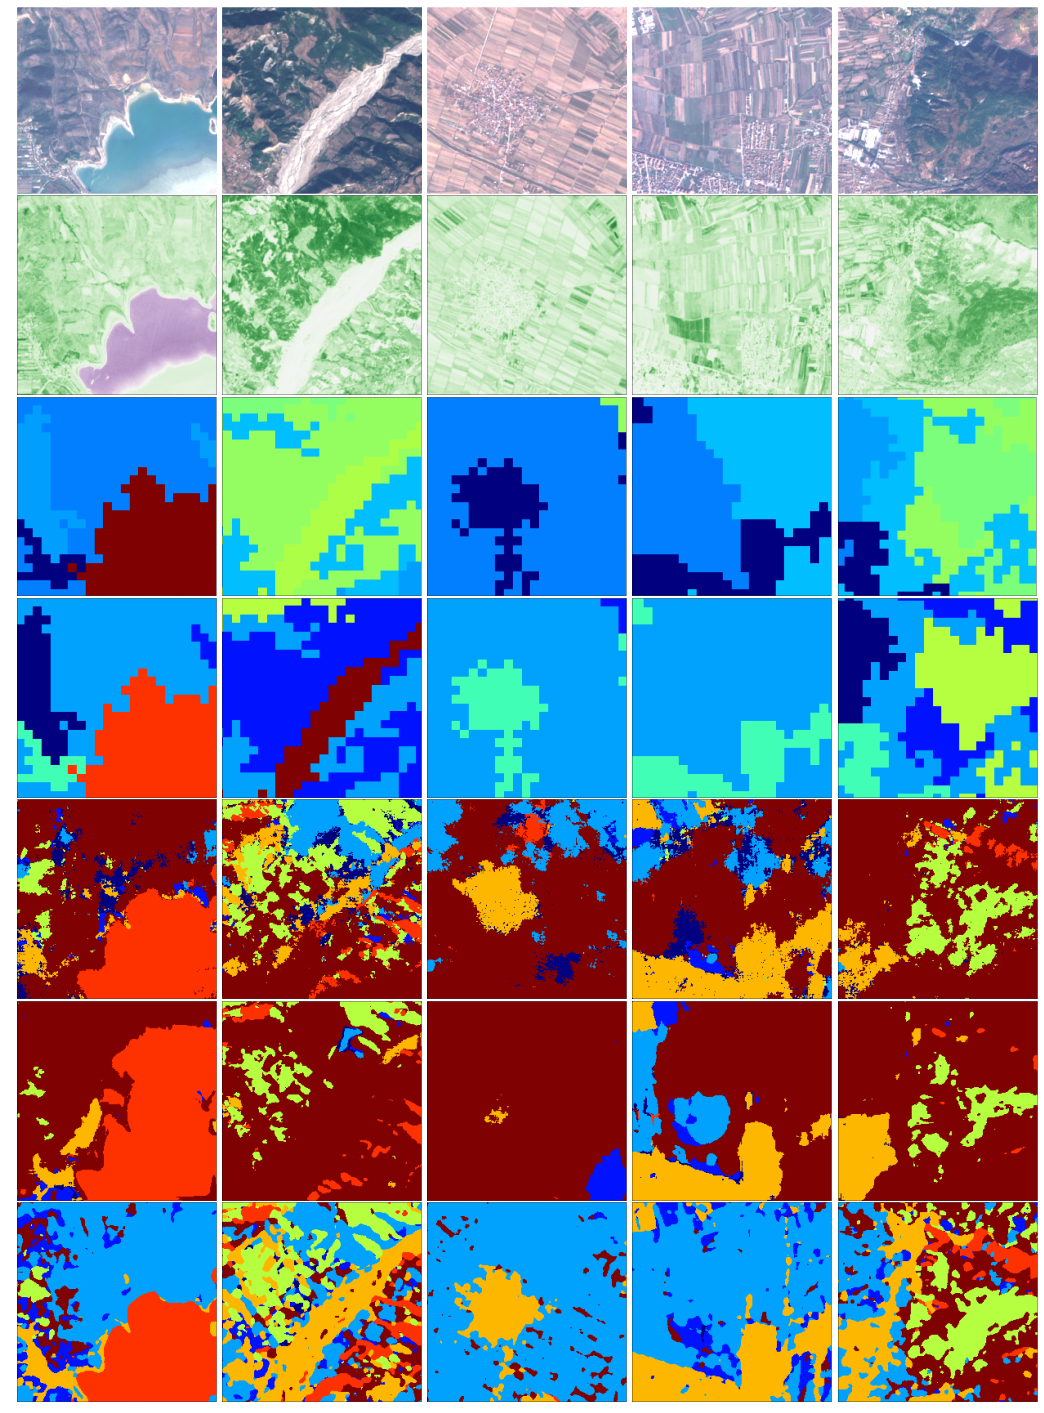
Figure 9. Checking the model robustness. Area of study: Albania. Reference layer: CORINE 2018 re-classified. Rows: (1) RGB composition of the input S2 imagery; (2) NDVI; (3) CORINE 2018; (4) CORINE 2018 re-classified; (5) SegNet-L1Cmix-244x244; (6) Unet-L1Cmix-244x244; (7) CNN-L1Cmix-5x5. The NDVI colormap ranges from value -1 (purple) to value 0 (white) and then to value 1 (dark green). The CORINE 2018 discrete colormap represents the respective classes shown in Table 6, 3rd column, as being ordinal values. The re-classified CORINE 2018 colormap as well as the colormap of the depicted models output follows the colour convention defined in Table 6, 1st and 2nd